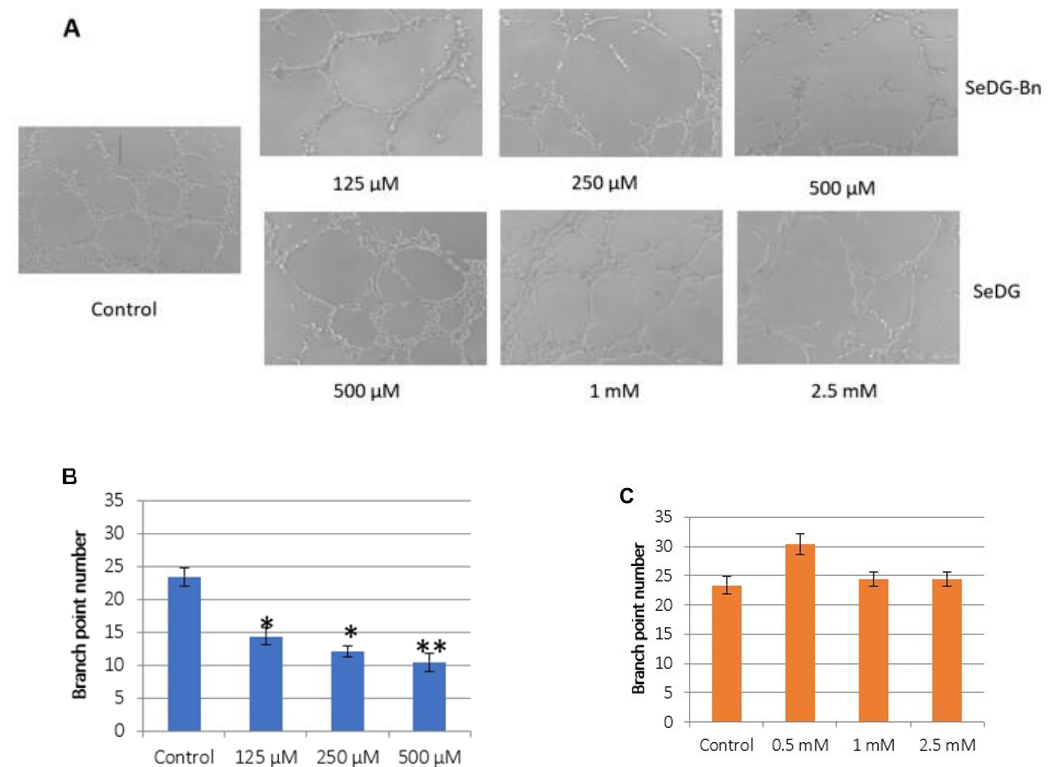
Figure 7. Capillary tube formation assay. ( A ) Representative images (10x magnification) of HuVec cells treated with SeDG-Bn and SeDG after 5 h of incubation at 37 °C. Quantitative analysis of branch point calculation for ( B ) SeDG-Bn and ( C ) SeDG, respectively. Data represent the mean ± SE of three individual experiments. ** p < 0.01 * p < 0.05